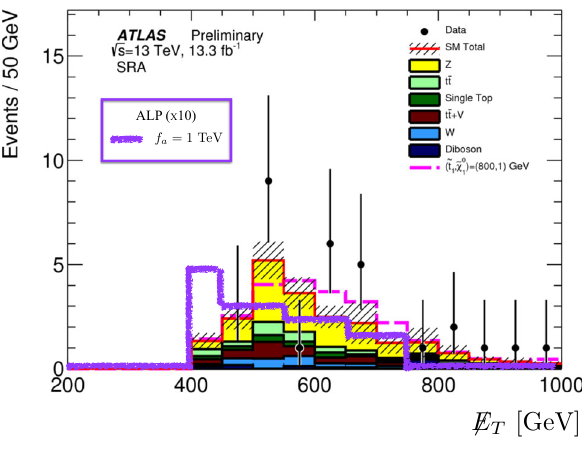
Fig. 14 Missing energy distribution for the production of an light ALP in association with t ¯ t for 13.3 fb − 1 of 13 TeV data. The normalisation has been chosen with f a = 1 TeV and then multiplied by a factor 10. We show the corresponding simulation of supersymmetric scenarios by ATLAS, as well as their event